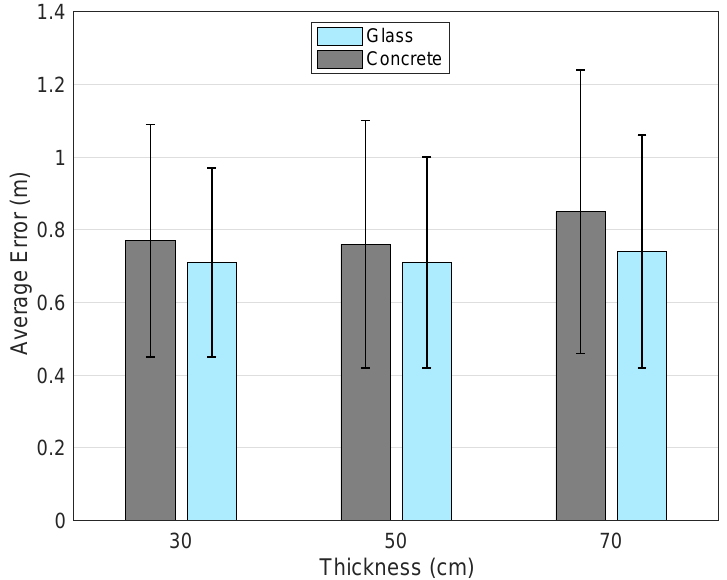
Figure 8. The effect of thickness for each obstruction material.